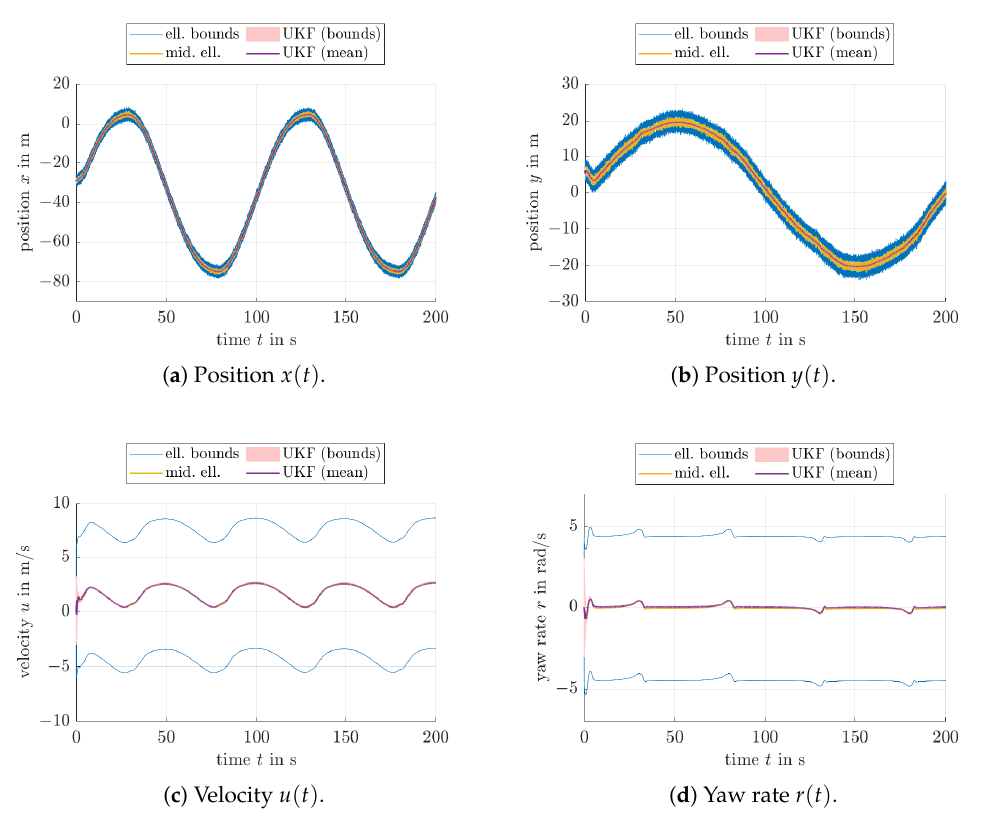
Figure 3. Estimation results with constant bounds for the uncertain system parameters: scaling factor r = 1 for the state prediction (1.44% confidence bound) with 99% confidence bounds of process and measurement